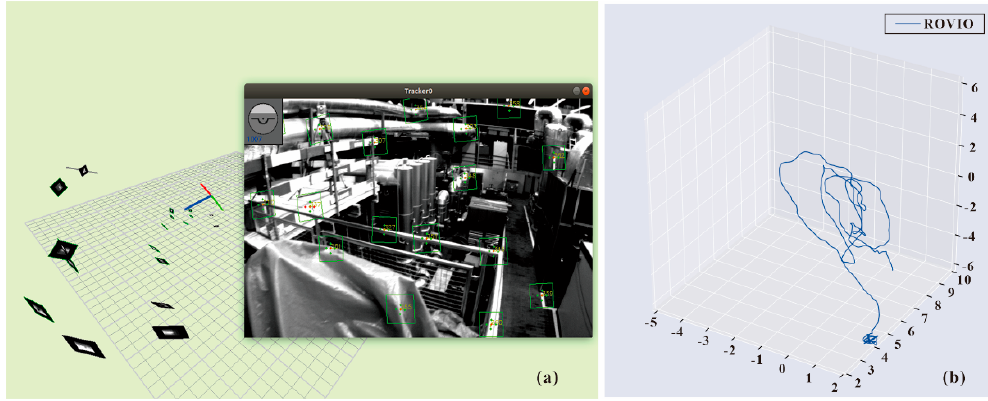
Figure 3. EuRoC public dataset ( a ) and trajectory ( b ).